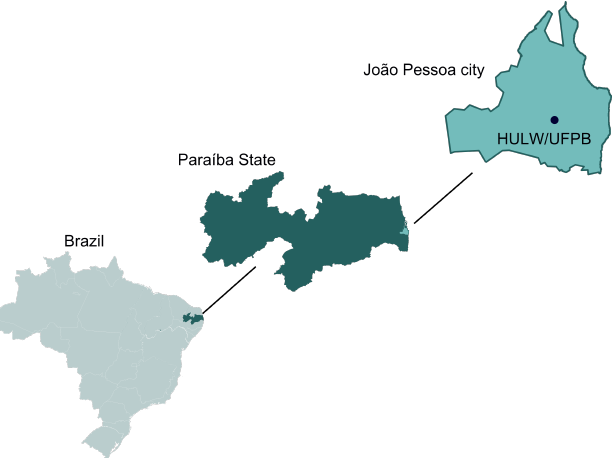
Figure 1. Approximate location of the Lauro Wanderley University Hospital at the Federal University of Paraíba (HULW/UFPB) in scale-amplified view. Source: prepared by the authors. HULW is a reference hospital in Paraíba State on several fronts of health sciences and was responsible for the treatment and recovery of thousands of patients infected by COVID-19. The Brazil Coronavirus Portal places Paraíba State as the 3rd out of 9 states belonging to the Northeastern region of Brazil, with 262 deaths per 100,000 inhabitants (Source: Ministry of Health’s Coronavirus Panel, https://covid.saude.gov.br. Data collected on 27 January 2023). HULW is also part of a large and complex network of more than 30 public hospitals and maternities linked to federal universities managed by the Brazilian Company of Hospital Services (EBSERH). In 2021 only, for example, the network managed approximately 294,000 hospitalizations, 5 million medical consultations, and 14 million medical examinations (Data collected from the 2021 EBSERH Integrated